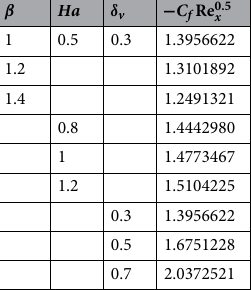
Table 2. Numeric values of